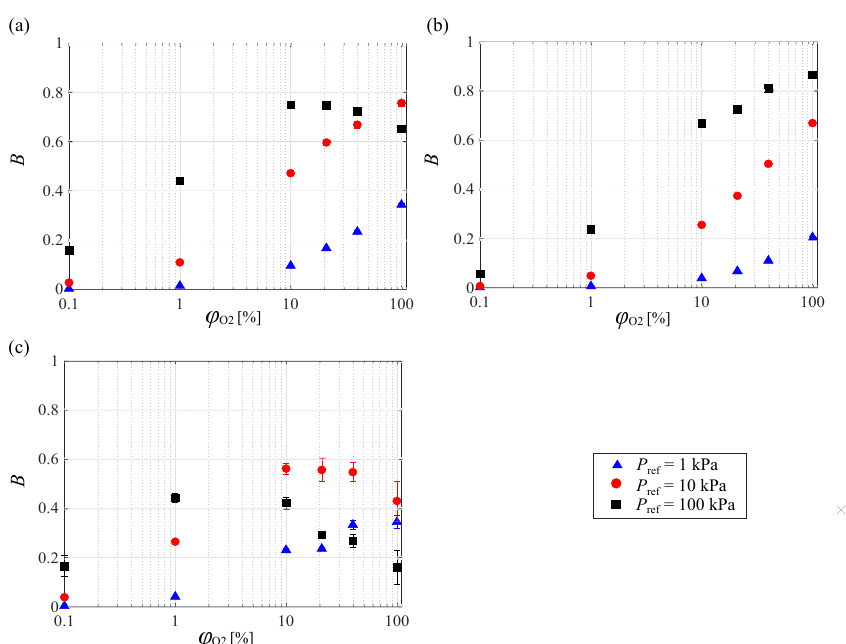
Figure 4. Effect of oxygen mole fraction on B in various pressure ranges for ( a ) PHFIPM-PSP, ( b ) PC-PSP, and ( c ) AA-PSP.